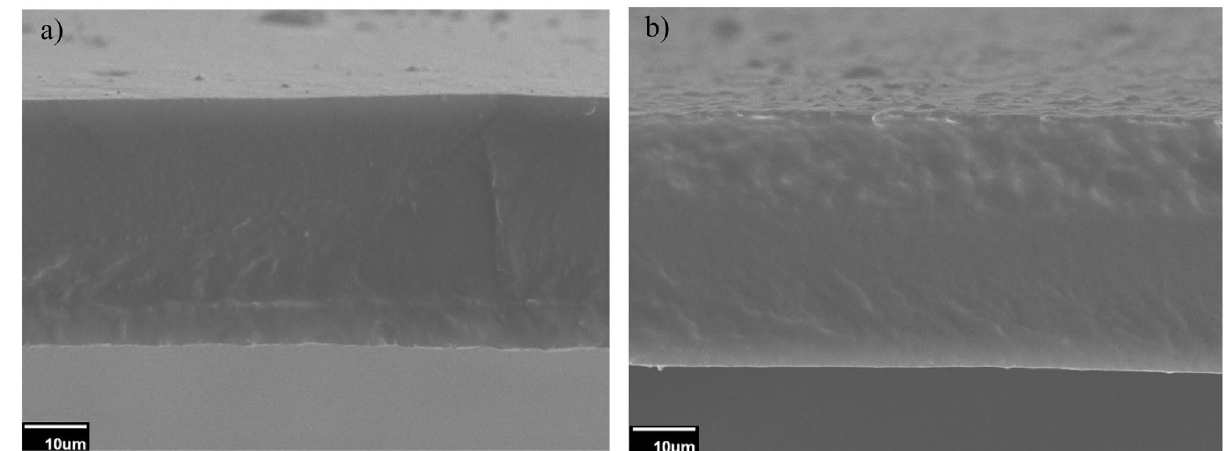
Figure 2. The cross-section SEM image of the TPU membranes: ( a ) TPU-1 and ( b )